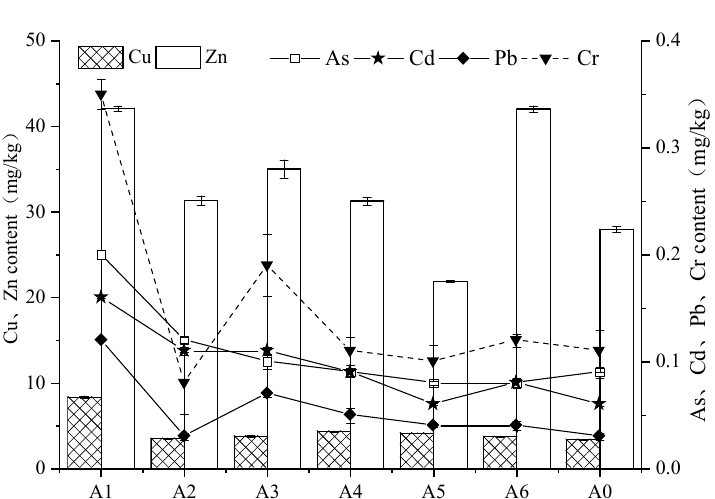
Figure 3. Changes in heavy metal contents in surface oyster soft tissues at different monitoring stations (wet weight).